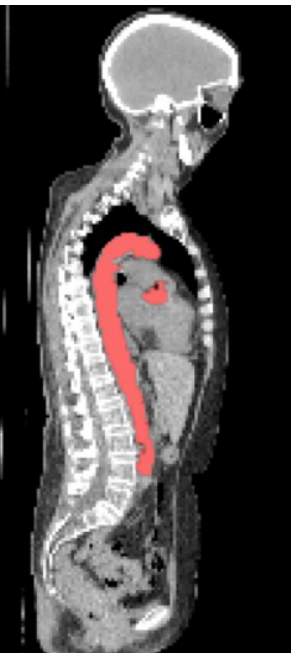
Figure 4. Segmentation from CNN with small ‘islands’